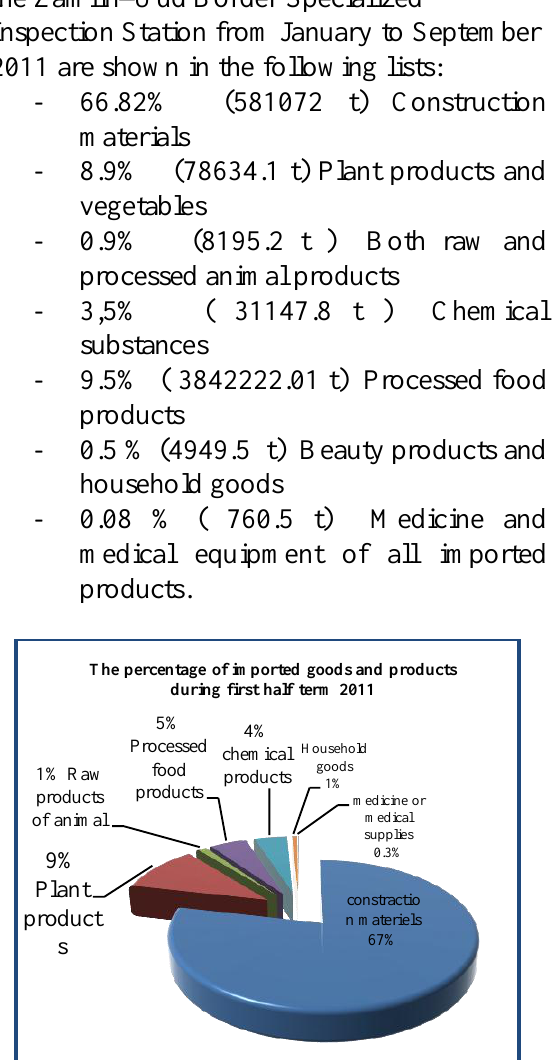
Figure1. The percentage of imported goods and products during first half of